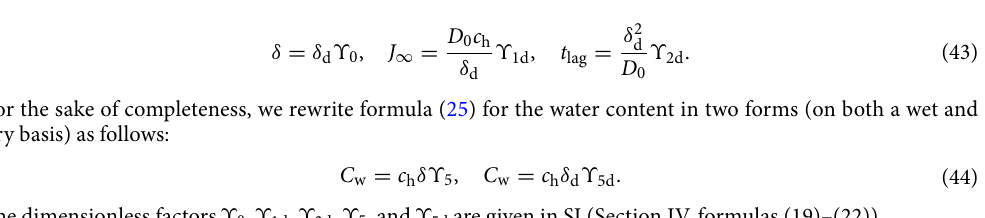
Figure 7. ( a ) Time-scaled variation of the post-occlusion SSWL based on data from Ref. 2 . The dashed lines correspond to the mean values of J 30 obtained from 26 young (19–42 years) and 18 old (69–85 years) subjects. ′′ ( b ) Time-scaled variation of the post-occlusion SSWL based on data from Ref. 26